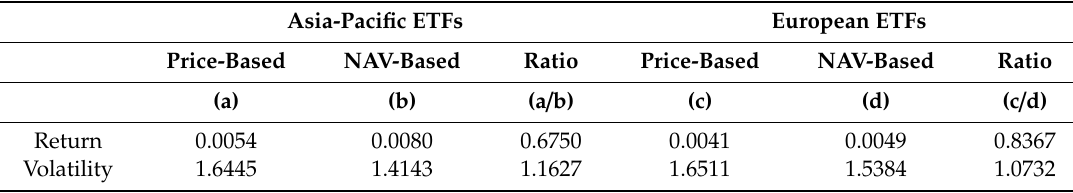
Table 2. Daily return and volatility analyses of International Exchange-Traded Funds (ETFs).